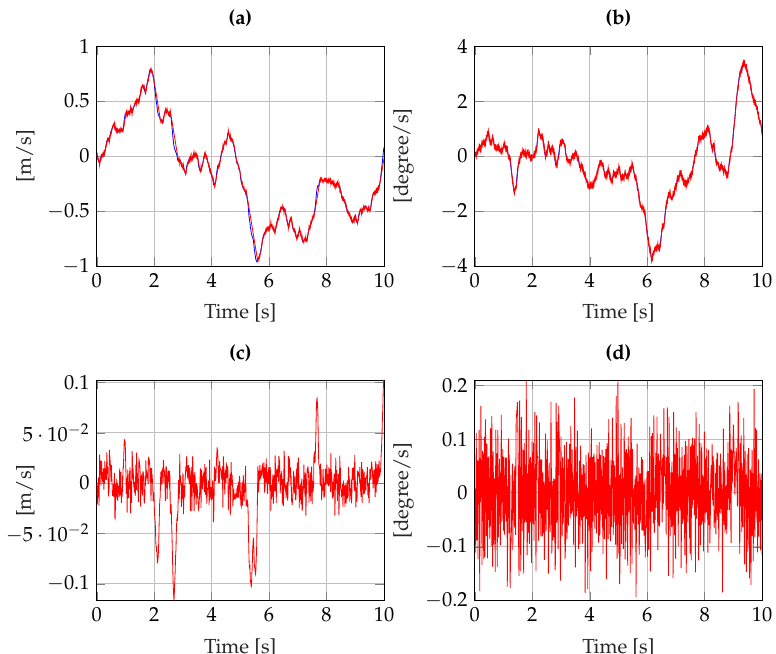
Figure 11. Disturbances estimations: ( a ) d x (blue) and ˆ d x (red), ( b ) d y (blue) and ˆ d y (red), ( c ) d x ˆ d (d) d y ˆ d y . − −